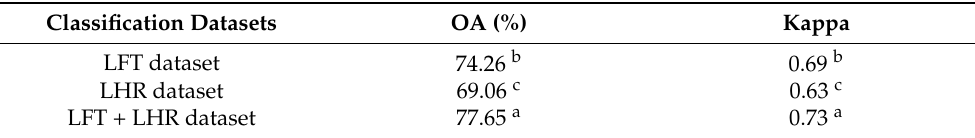
Table 2. OA (%) and Kappa based on different classification datasets.